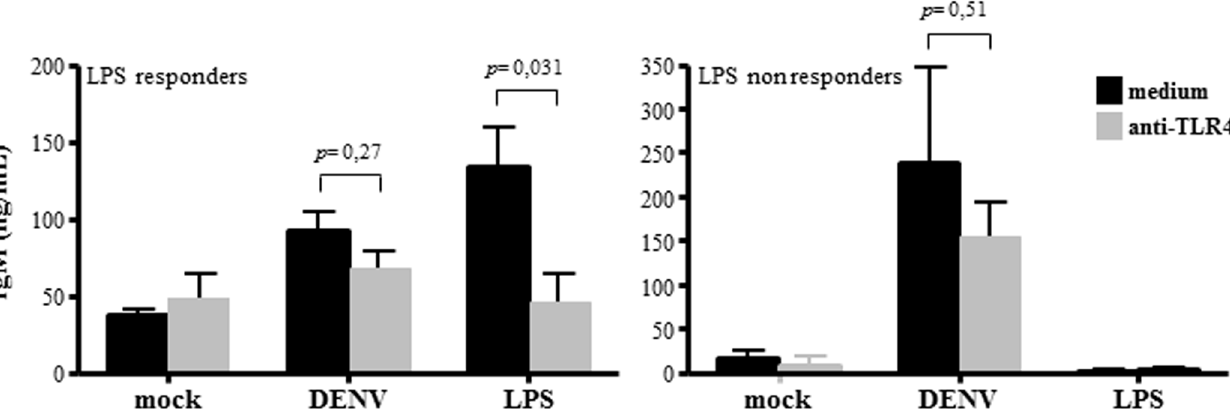
Fig 5. DENV-induced IgM secretion does not depend on TLR4 activation. B lymphocytes were mock-treated or cultured with DENV2 (MOI = 1) in the presence or absence of anti-TLR4 neutralizing antibody. LPS (10 μ g/ml; Sigma Aldrich) was used as positive control. At 12 days post infection, the supernatants were harvested and IgM levels were measured by ELISA. B cell cultures which showed increased IgM secretion in response to LPS (LPS responders) were graphed separately from the ones that didn ’ t show (LPS nonresponders). Data are representative of four independent experiments. Statistical analysis were performed and p values are indicated in the